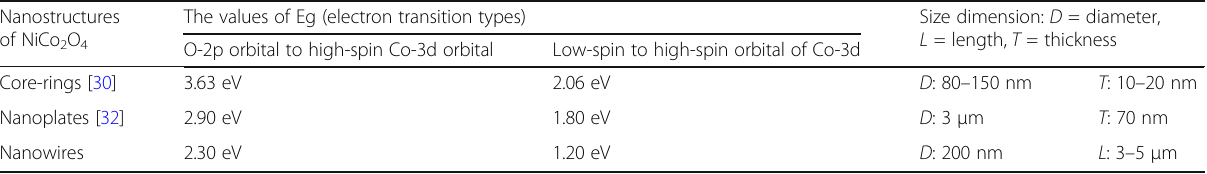
Table 1 Comparison of reported band gap values of different NiCo 2 O 4 nanostructures Nanostructures The values of Eg (electron transition of NiCo 2 O 4